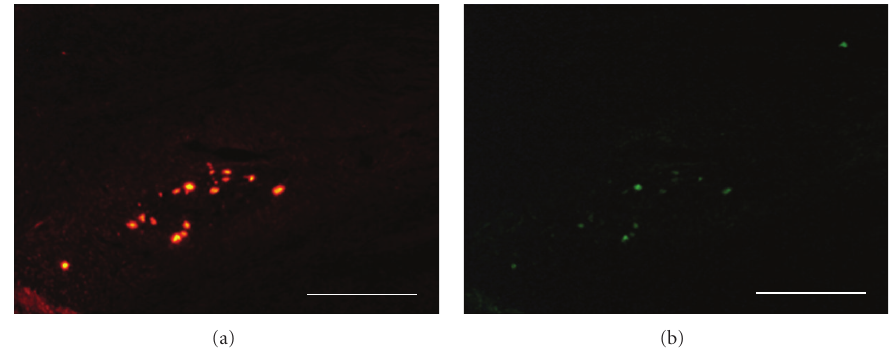
Figure 4: Double BrdU-DCX immunohistochemistry on a sagittal section from a neurosphere-grafted bridged nerve at 8 days after lesion. One given field was sequentially photographed with fluorescent wavelengths revealing, respectively, Alexa-594-labeled BrdU immunoreactivity (a) and Alexa-488-DCX one (b). Note the extensive nuclear colocalization of the immature neuron marker DCX with BrdU (b). Scale bars